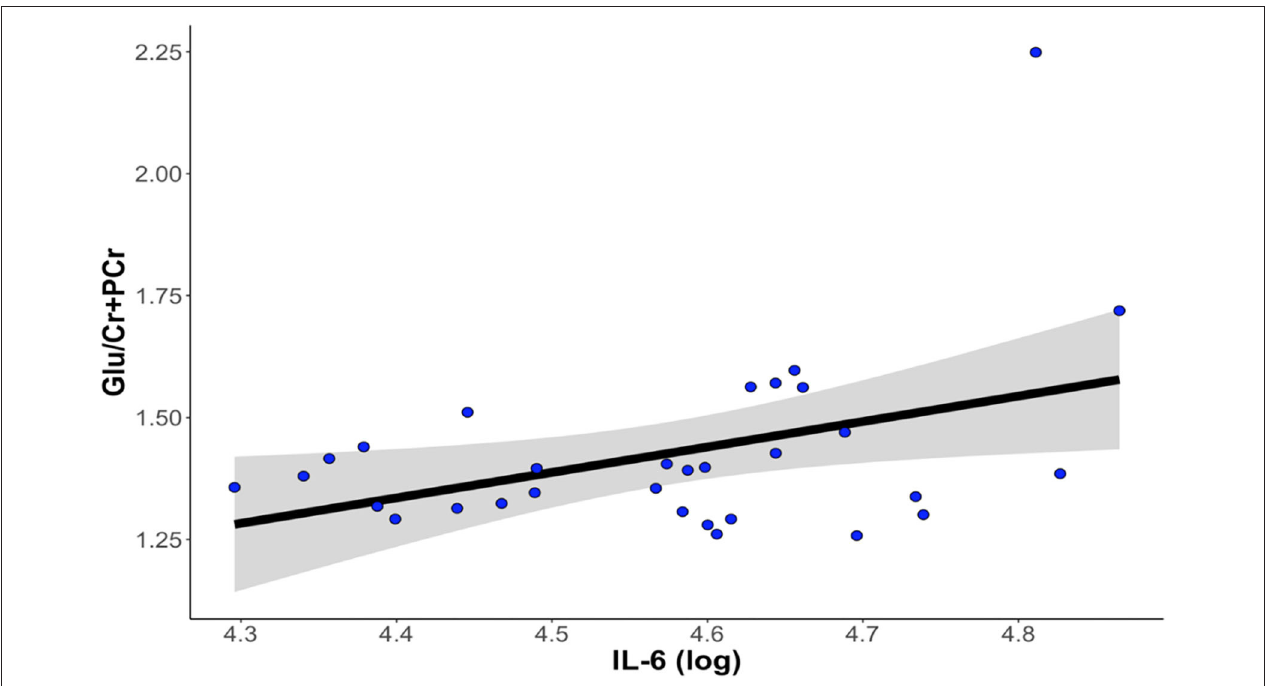
FIGURE 3 | Higher levels of IL-6 at baseline are associated with higher levels of Glu in the dorsal anterior cingulate cortex. The correlation between IL-6 and dACC Glu remained statistically significant after controlling for age, gender, percentage of gray matter volume in the dACC voxel, antidepressant medication usage, and anti-inflammatory medication usage. dACC, dorsal anterior cingulate cortex; Glu, glutamate; IL-6, interleukin-6.